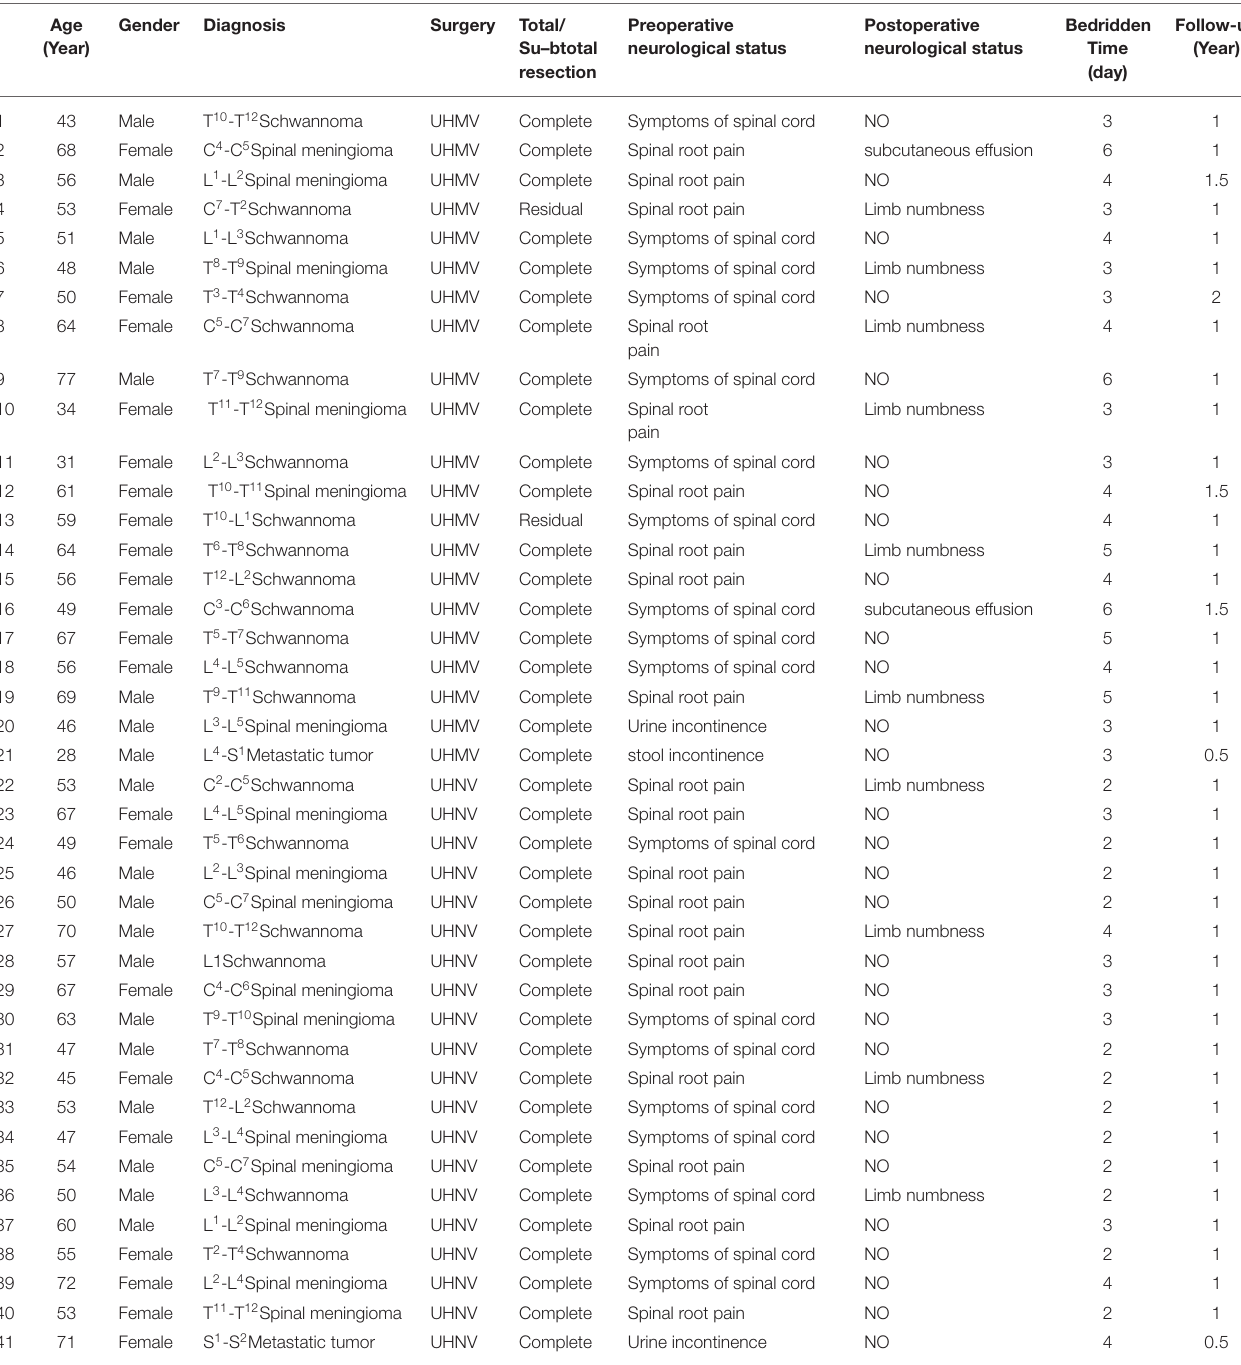
TABLE 2 | Basic characteristics of 41 patients. Age